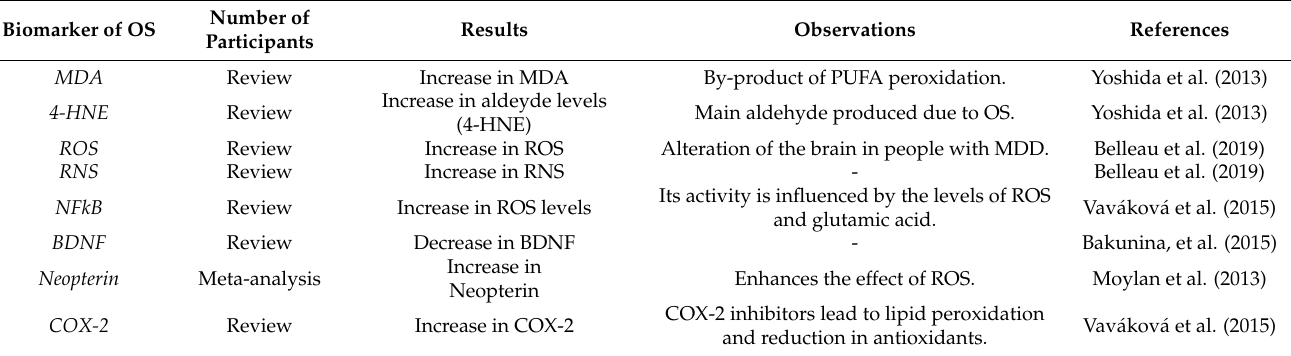
Table 1. Summary of OS biomarkers in